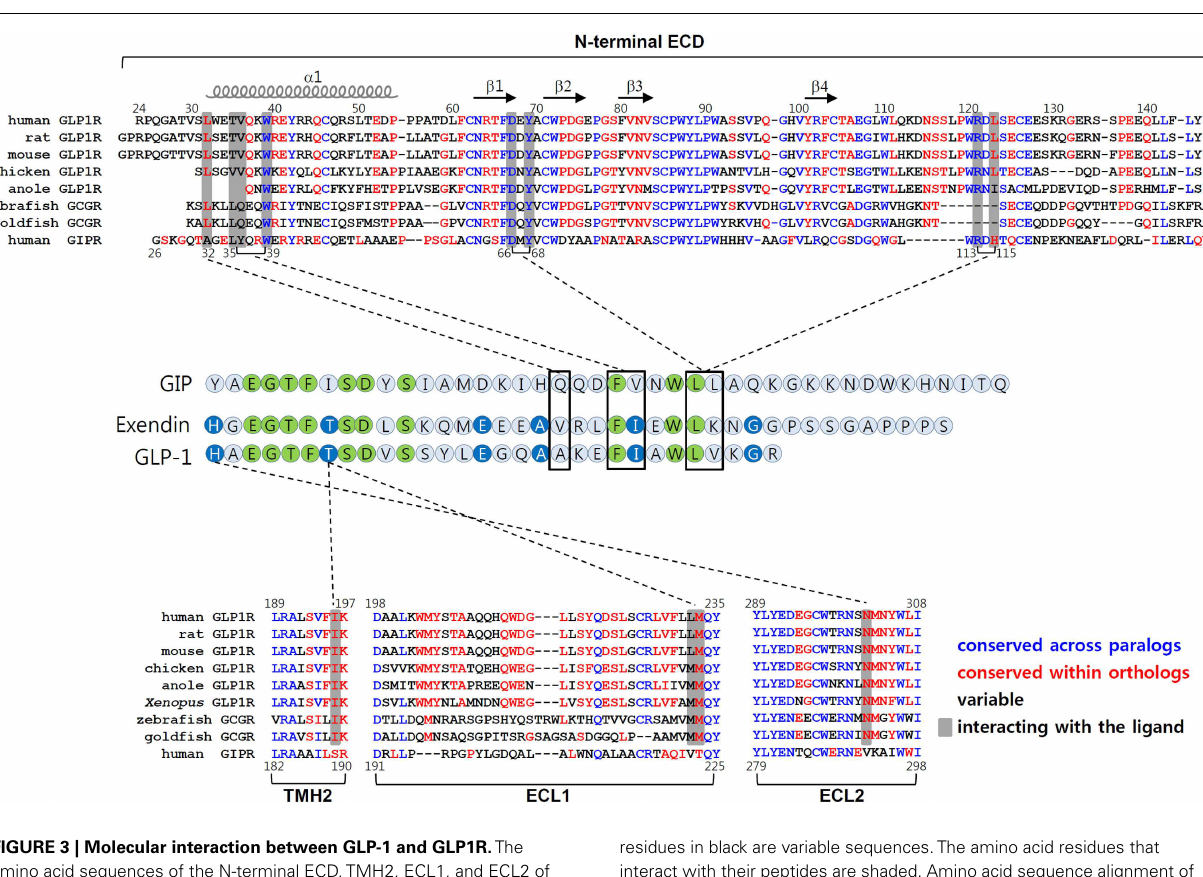
residues in black are variable sequences.The amino acid residues that interact with their peptides are shaded. Amino acid sequence alignment of GLP-1, exendin, and GIP are shown in the middle. Residues which are identical among three peptides are in green. Residues common for GLP-1 and exendin are in blue.The interaction between peptides and receptors are indicated by dotted